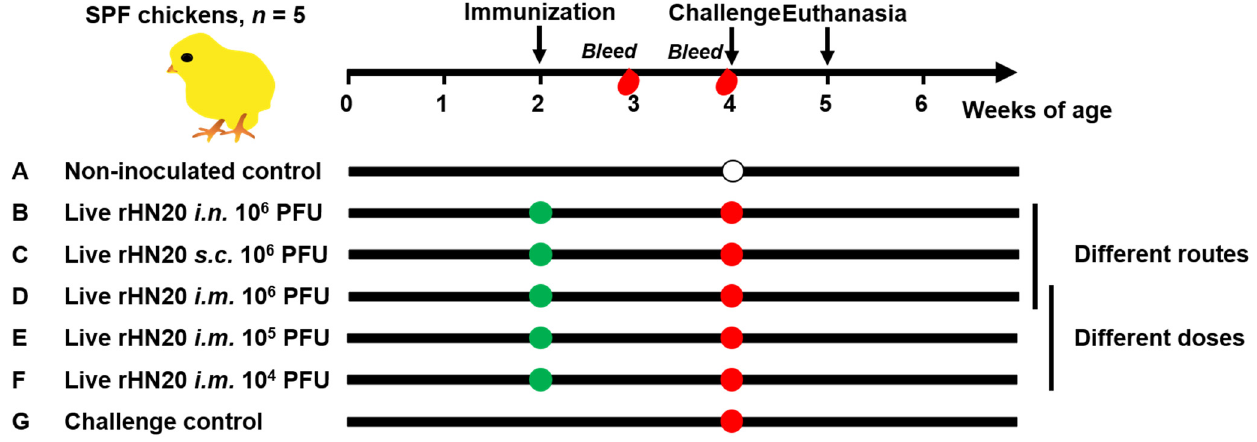
Figure 1. Schematic diagram of animal experiment design. SPF chickens were immunized at 2 weeks of age and blood was collected at 3 and 4 weeks of age. The chickens were challenged at 4 weeks of age and euthanized at 5 weeks of age. Seven groups with 5 chickens in each group were evaluated. Group (A) was neither immunized nor challenged as non-inoculated control group, and group (G) was not immunized but challenged as a control group. Groups (B–D) were immunized with 10 6 PFU rHN20 through the intranasal ( i.n. ), subcutaneous ( s.c. ) or intramuscular ( i.m. ) routes. Groups (D–F) were immunized with different doses including i.m. 10 6 , 10 5 , and 10 4 PFU. Among them, group (D) i.m. 10 6 PFU was treated using different routes and doses.